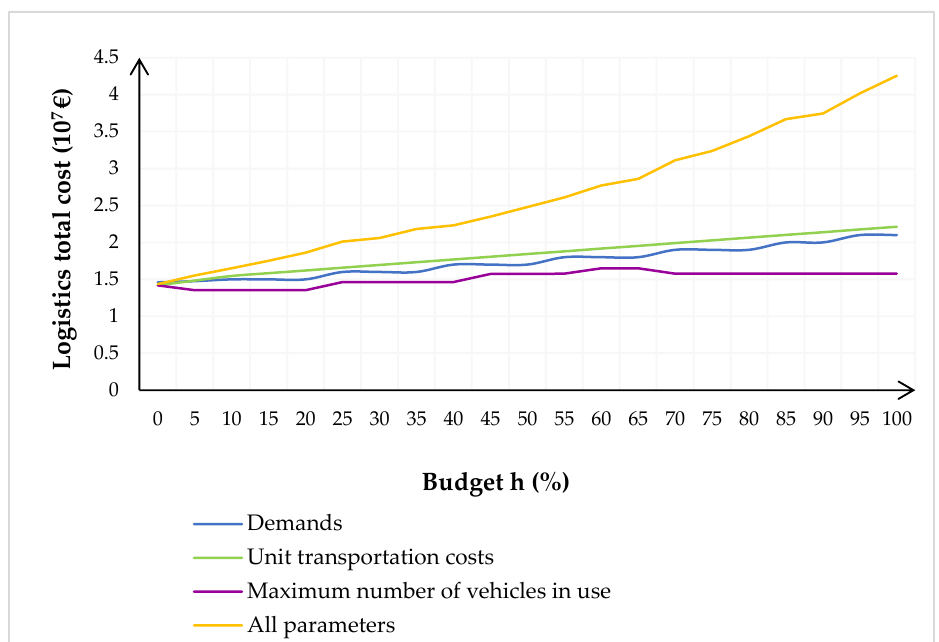
Figure 5. Impacts of the uncertainty budget on the total logistical cost (EUR 10 7 ).